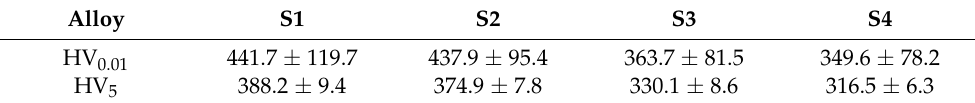
Table 3. Microhardness and Vickers hardness values of the alloys.